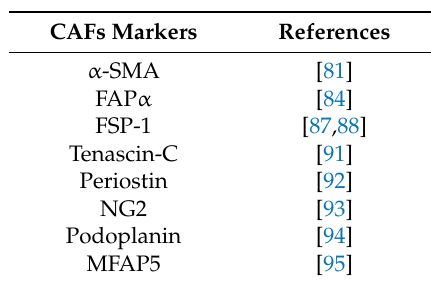
Table 1. Markers of